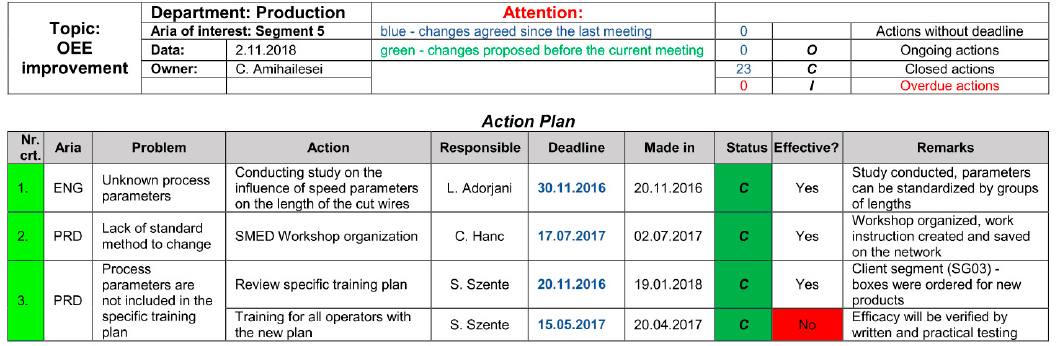
Figure 2. Action Plan.